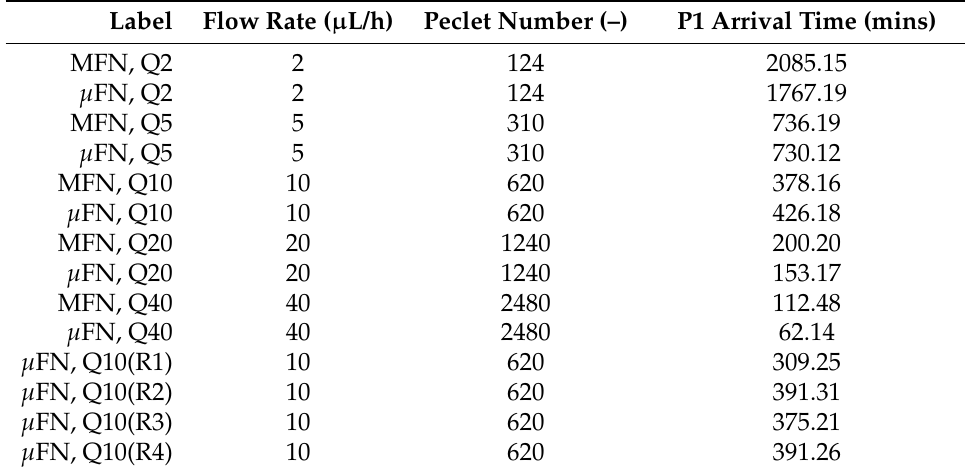
Table 4. Experiment flow rates, Péclet number and P1 arrival time.